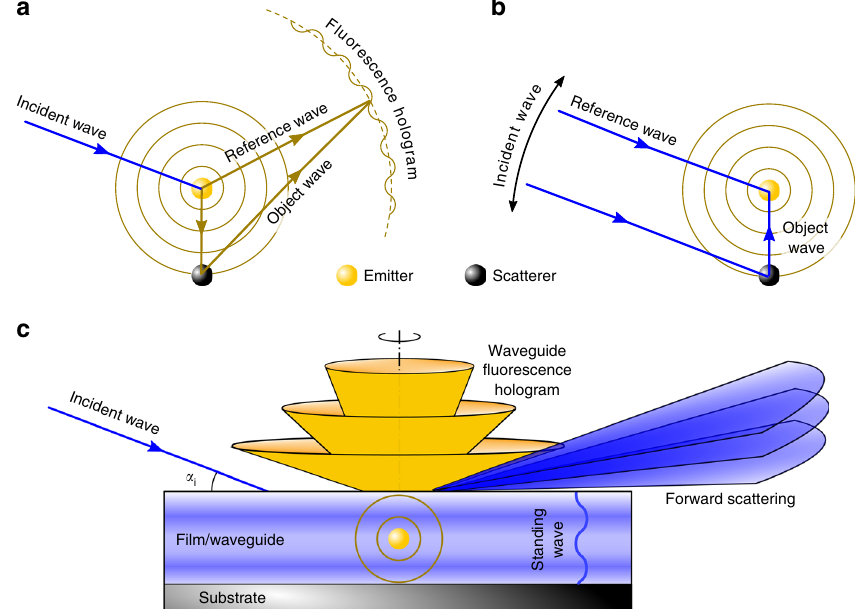
Fig. 1 Schematics of X-ray fl uorescence holography (XFH) operation modes. a In the normal XFH mode 1 , an emitting atom (i.e. emitter) gives out a spherically outgoing X-ray fl uorescence wave. An object wave is formed when this outgoing wave is scattered by a nearby atom (i.e. scatterer) and then interferes with the unperturbed outgoing reference wave, producing a spatially distributed hologram. Lines in blue and gold colors represent waves of elastic and fl uorescence energies, respectively. b In the inverse XFH mode 4 , the exciting wave at the emitter is a result of interference of the unperturbed incident wave and the scattered incident wave from the scatterer. The hologram is constructed by scanning the incident wave and recording the integrated fl uorescence intensity at a fi xed detector position. c In the mixed-mode X-ray waveguide fl uorescence holography (XWFH) at grazing-incidence and exit angles, X-ray standing waves are created within the waveguide for both the elastic and fl uorescence energies. The intensity of fl uorescence leaving the waveguide concentrates at discrete exit angles, producing a concentric cone-like hologram whose axis of rotation is perpendicular to the fi lm surface. The forward elastic scattering is also modulated by the waveguide and its angular dependence is measured via grazing-incidence small-angle X-ray scattering